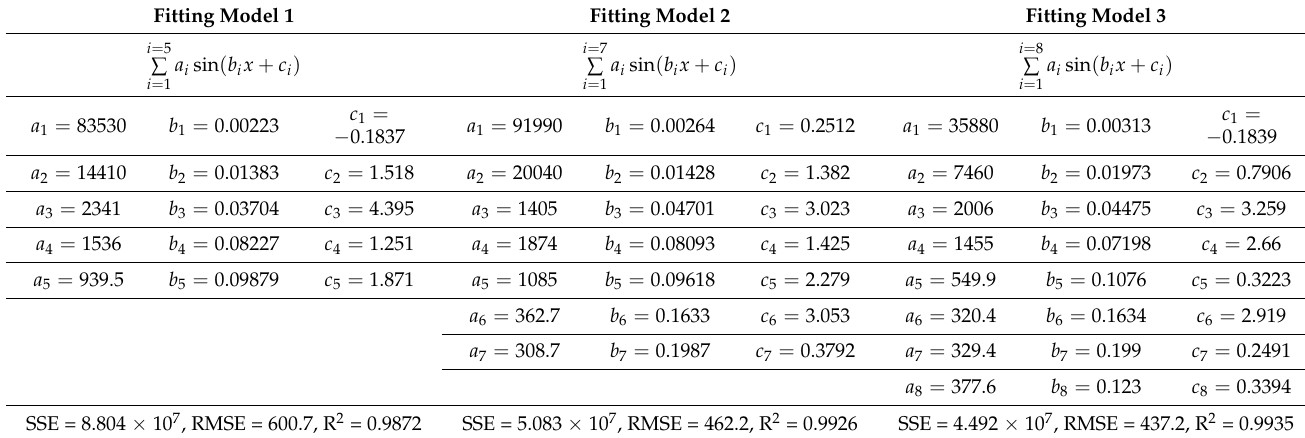
Table 9. Used mathematical fitting models for Russia data with optimized